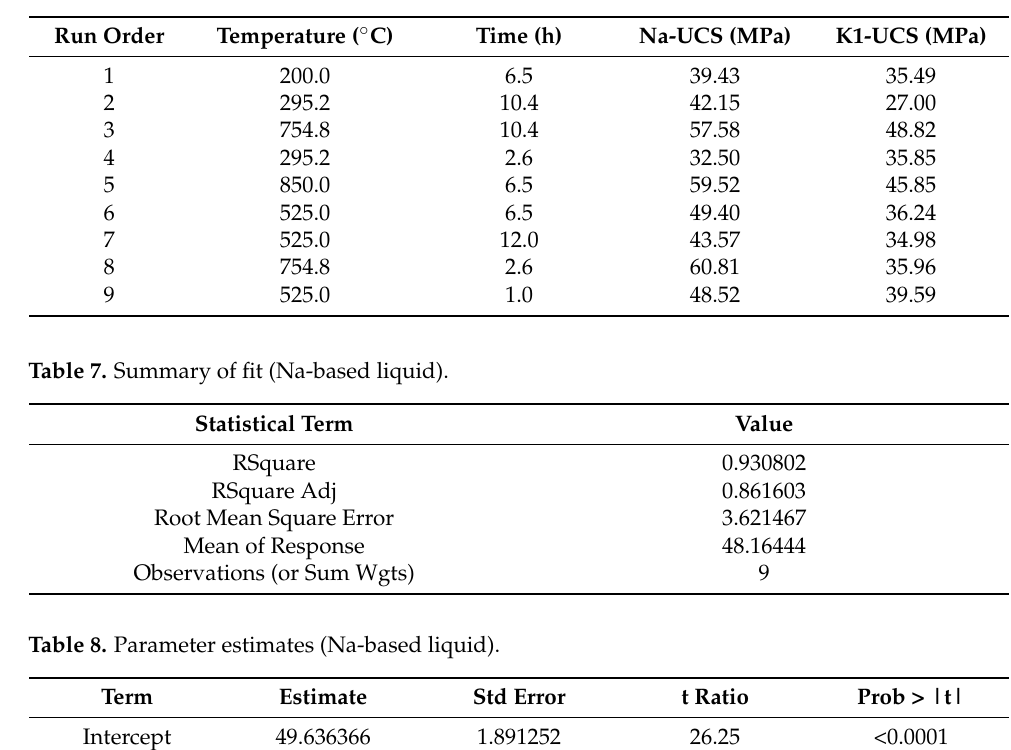
Table 6. Compressive strength obtained for different calcination conditions (DOE).